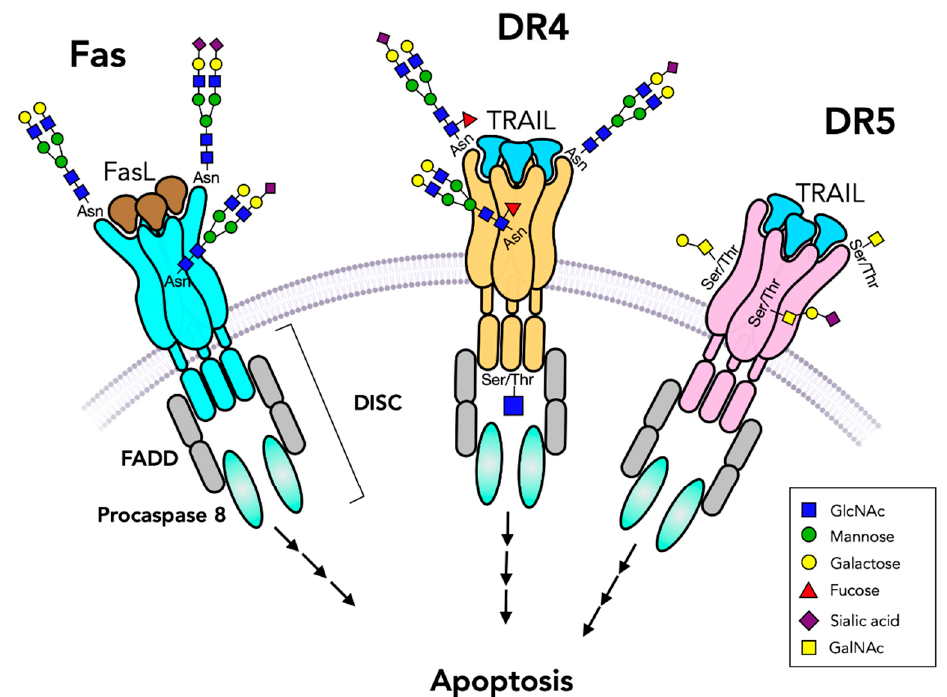
Figure 4. Death receptors initiate apoptosis pathways. Fas and TNF α -related apoptosis-inducing ligand (TRAIL) receptors bind to a trimeric ligand (FasL or TRAIL) and form trimeric receptors that initiate caspase cleavages and apoptosis signaling pathways through Fas-associated protein with death domain (FADD) and death-inducing signaling complex (DISC). Fas has two N -glycans while DR4 has only one N -glycan and DR5 has no N -glycans. Both DR4 and DR5 have O -glycans. O -GlcNAc residues may be present on the cytoplasmic domain. TRAIL receptors are also controlled by their N -glycans. The presence of unmodified GalNAc residues (Tn antigen) leads to attenuation of receptor functions.